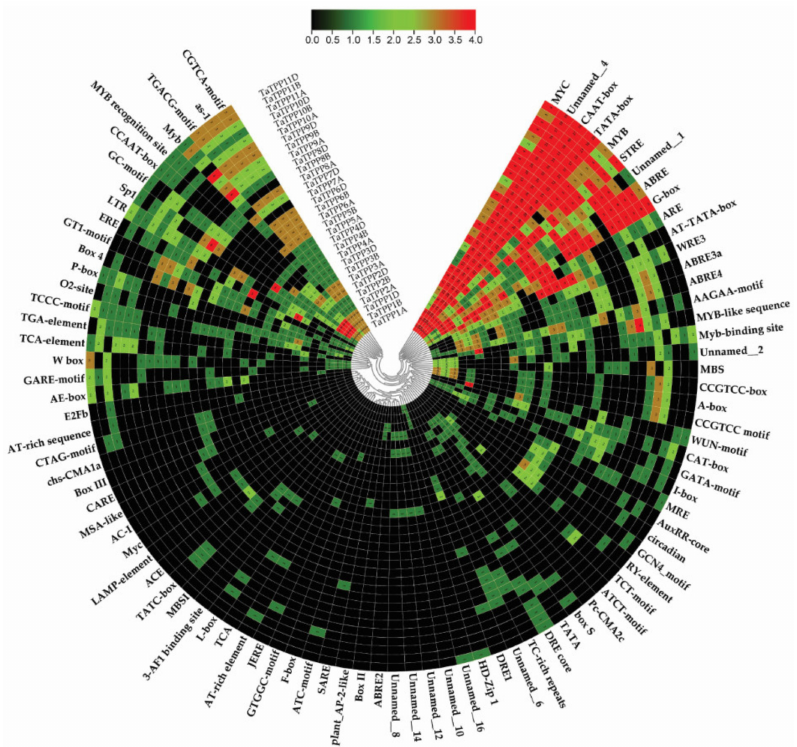
Figure 7. Putative Cis -acting regulatory elements (CREs) of TaTPPs . The CREs were identified with the 2 kb upstream sequences of the start codon using the PlantCARE online server and presented using TBtools. Red color indicates the CREs with high frequency, while black color indicates CREs with zero